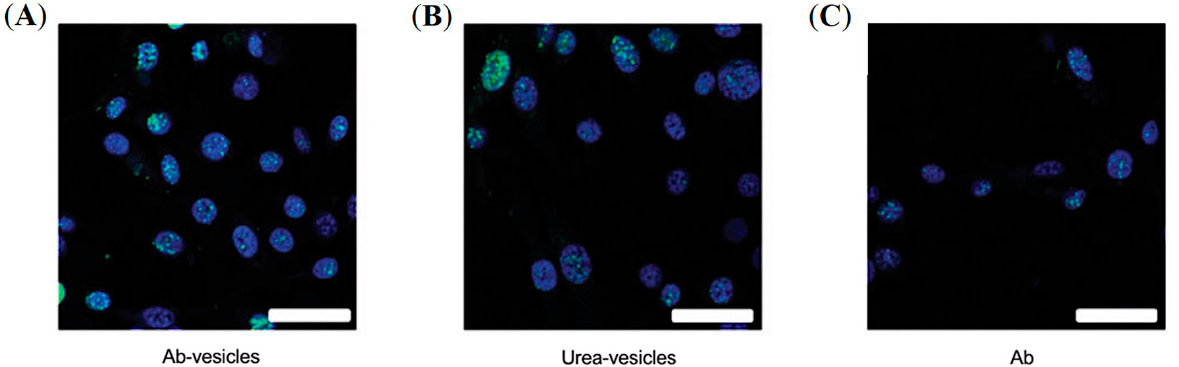
Figure 9. Treatment of prostate cancer using PSMA-targeted, 225 Ac-labelled liposomes. Immunofluo- rescent images of g-H2AX foci (green) in cell nuclei (blue) upon treatment with Ab-targeted vesicles ( A ), urea-targeted vesicles ( B ), and radiolabeled Abs ( C ). Scale bar, 40 mm. Reprinted with permission from Ref [63]. Copyright 2016, American Association of Cancer Research.